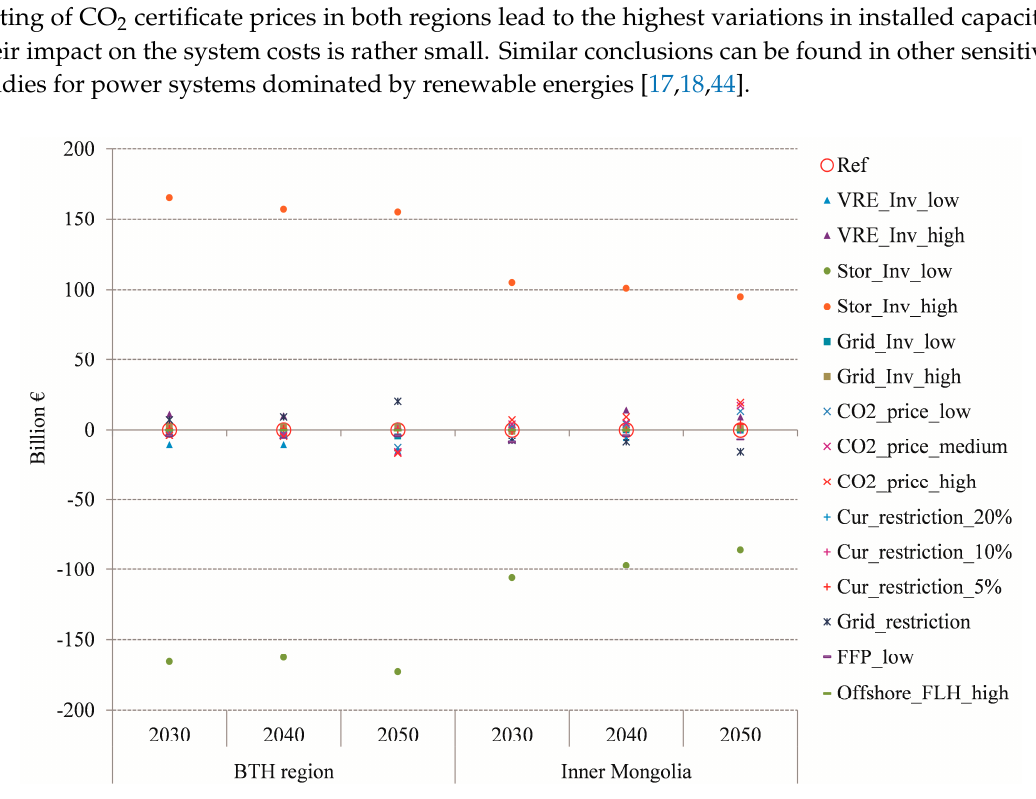
Figure 21. Sensitivity analysis on system costs from 2030 to 2050 in both regions shown as deviations from the reference scenario. from the reference